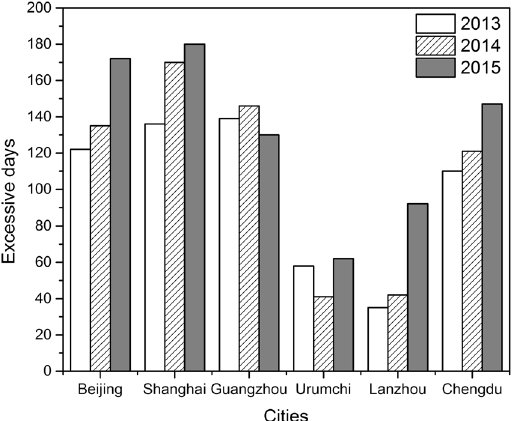
Figure 13. The number of days of exceeding the maximum daily eight-hour average (MDA8) concentrations of ground-level ozone in six cities during